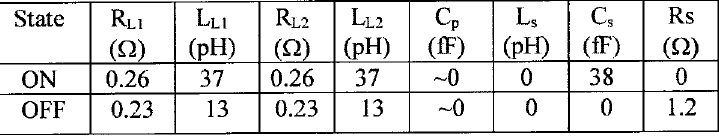
FIGURE 12 The modeled data vs. measurement data for a